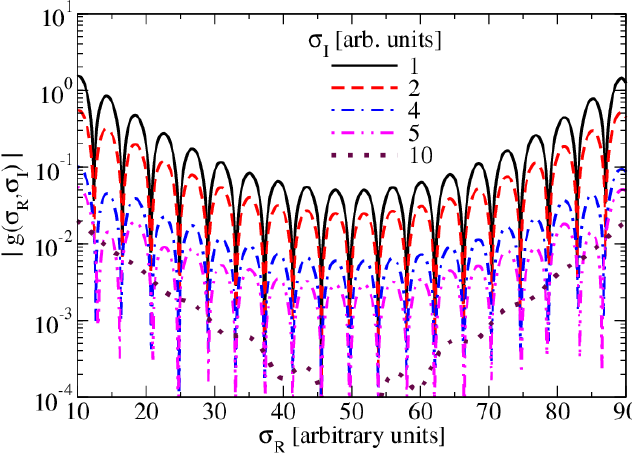
) for the σ equal to 1, 2, 4, 5, and 10 units , σ R I